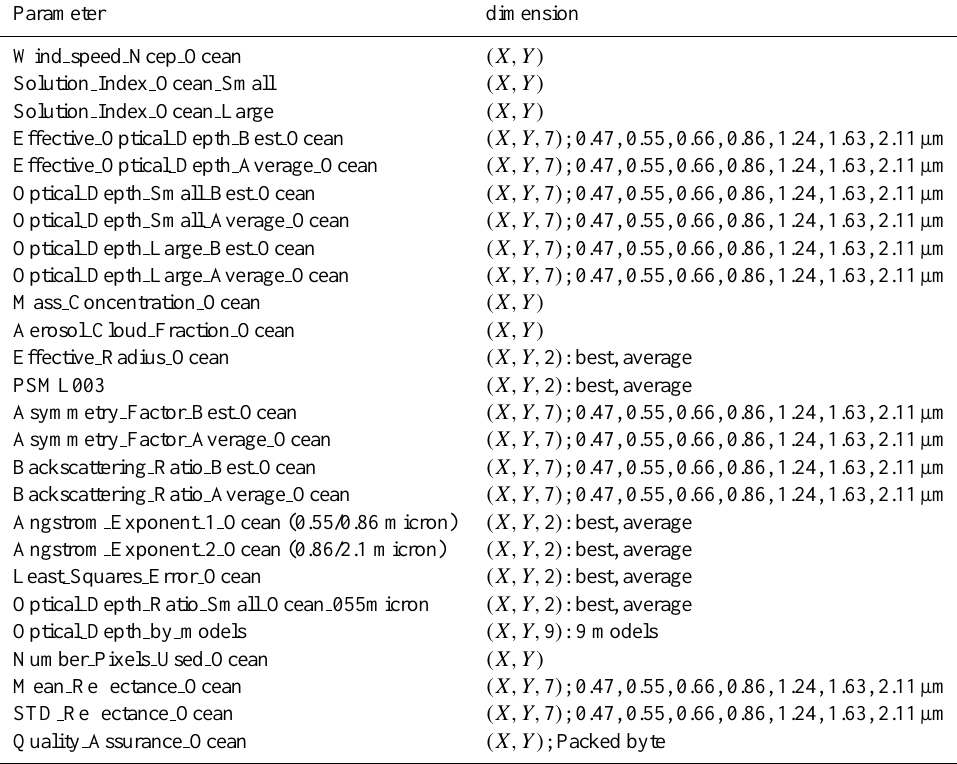
Table 2. Ocean parameters of the MOD/MYD04 3K file and the parameter’s dimension. Parameter dimension